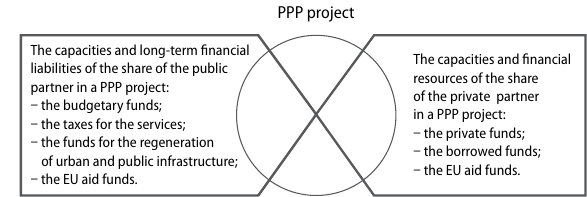
fig. 4. The interaction between the Eu aid and PPP in case of the ESCo